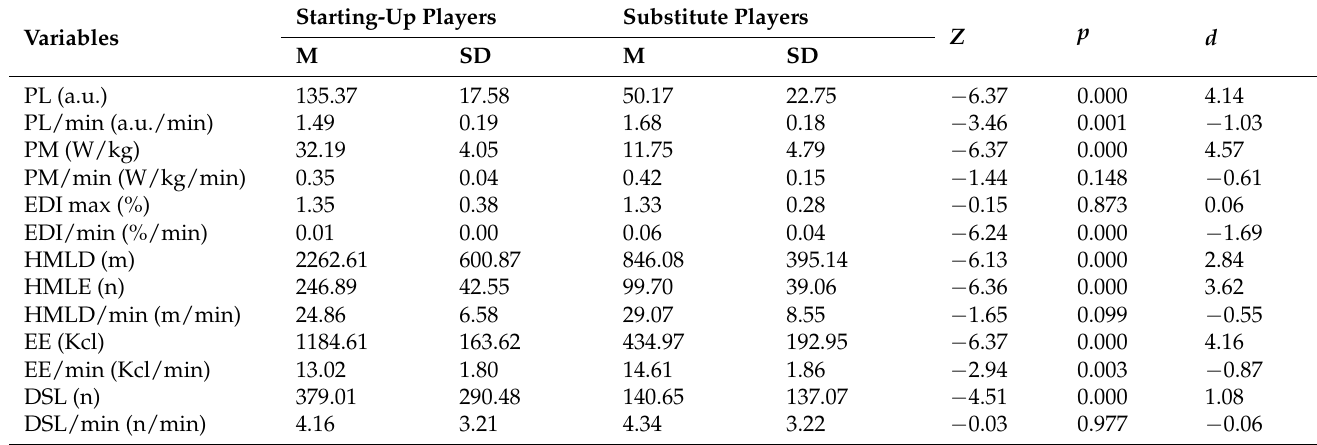
Table 2. Descriptive and difference analysis in relation to playing time in external load variables.